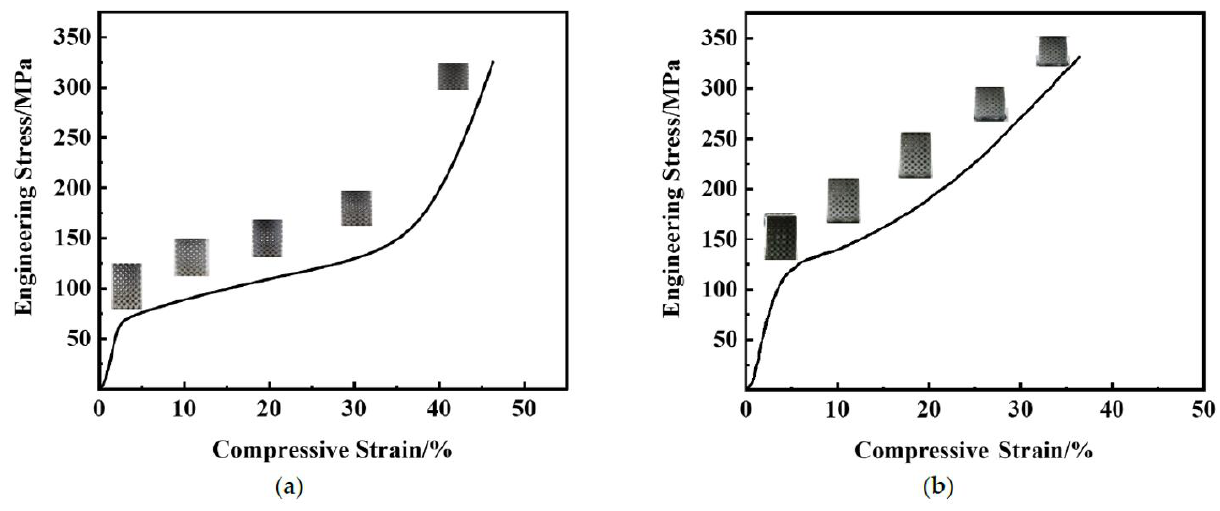
Figure 6. The curves of compressive stress–strain: ( a ) the 316L metallic lattice structure, ( b ) epoxy/316L metallic lattice composites.